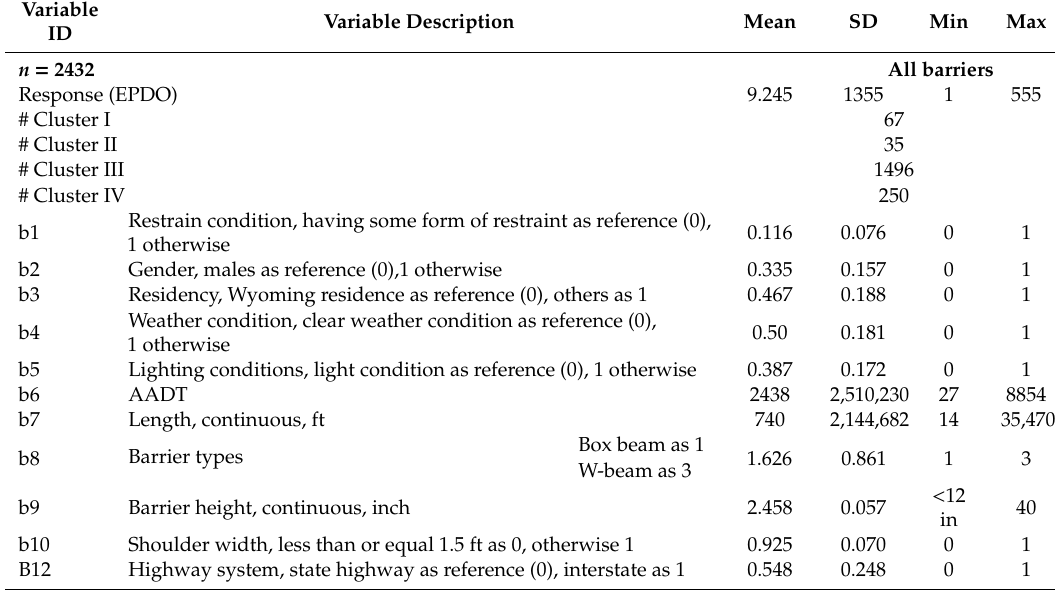
Table 1. Descriptive statistics of the trained